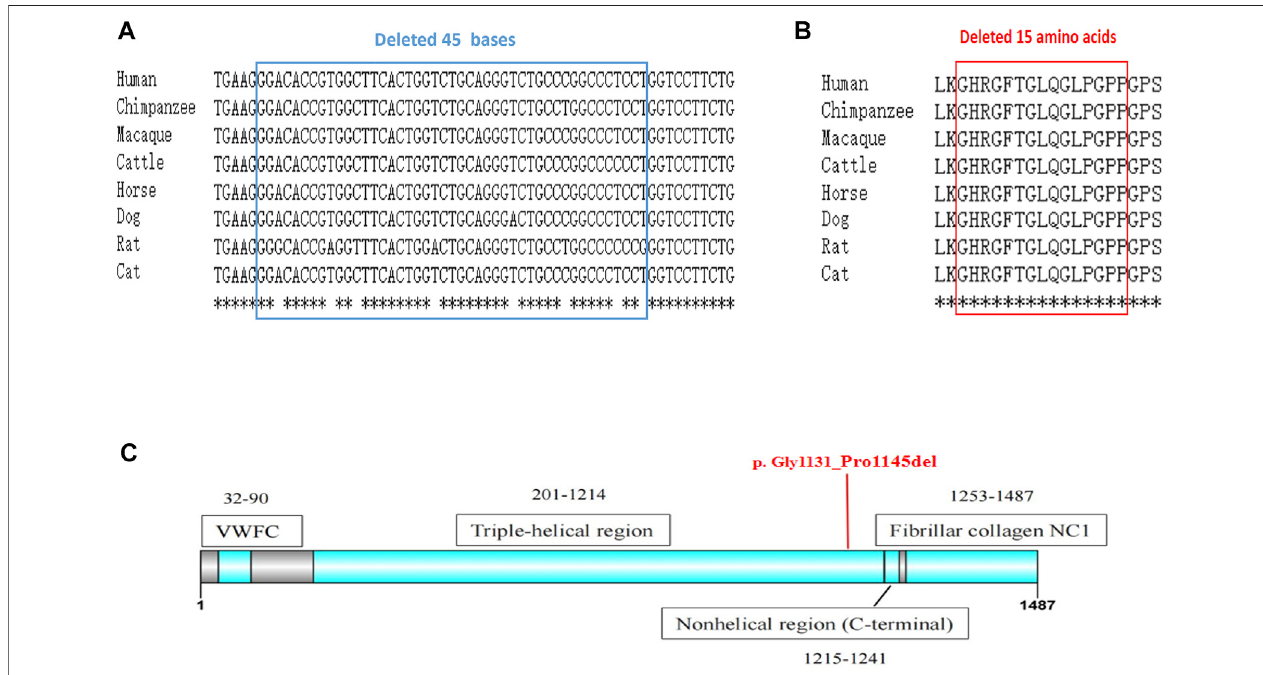
FIGURE 4 | The conservation analysis and location of the mutation. (A) Alignment of COL2A1 DNA sequences from multiple species. The affected bases affected by our novel mutation are highly conserved during evolution. (B) Alignment of COL2A1 amino-acid sequences from multiple species., analyzed by Online clustal omega (https://www.ebi.ac.uk/Tools/msa/clustalo/). (C) The deleted 15 amino acids locate in the triple helix region of COL2A1. The secondary structure of the protein is obtained from the uniprot